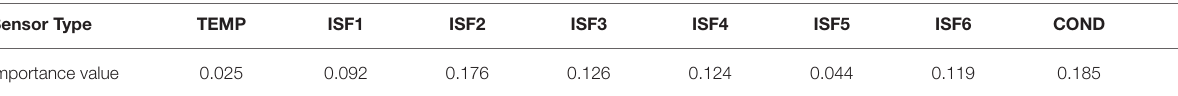
TABLE 6 | Sensor importance values estimated using the random forest algorithm. Sensor Type